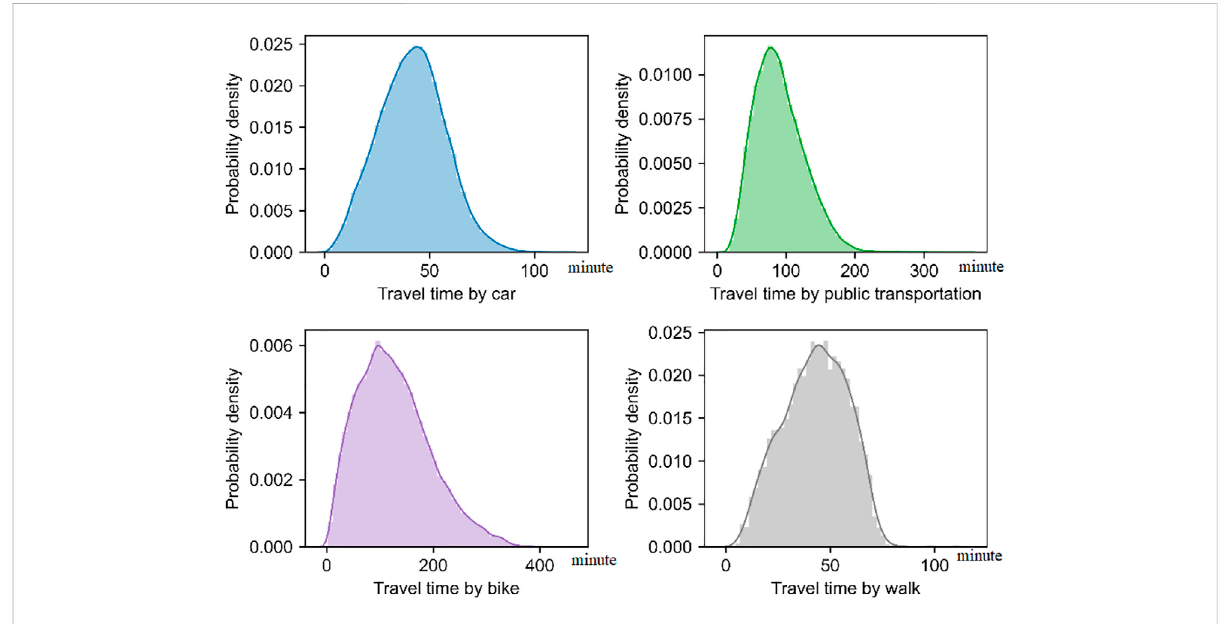
FIGURE 4 Distribution of travel time by four travel modes in different